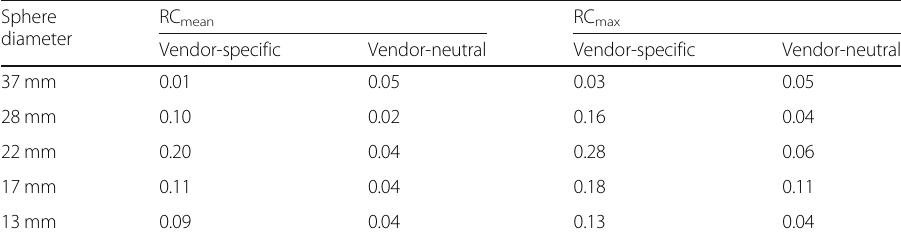
Table 6 MAD per sphere diameter for all systems combined, using either vendor-specific or vendor-neutral reconstruction